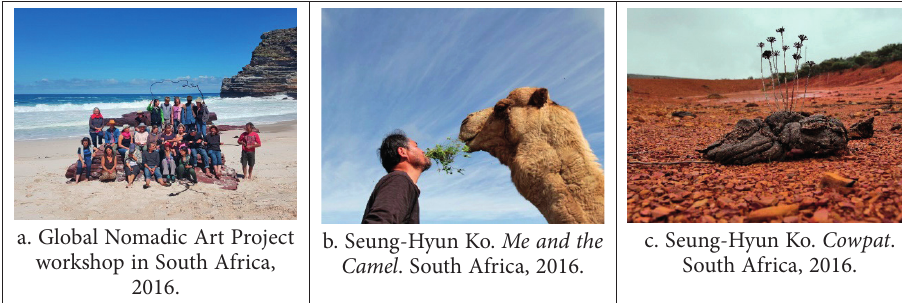
a. Global Nomadic Art Project workshop in South